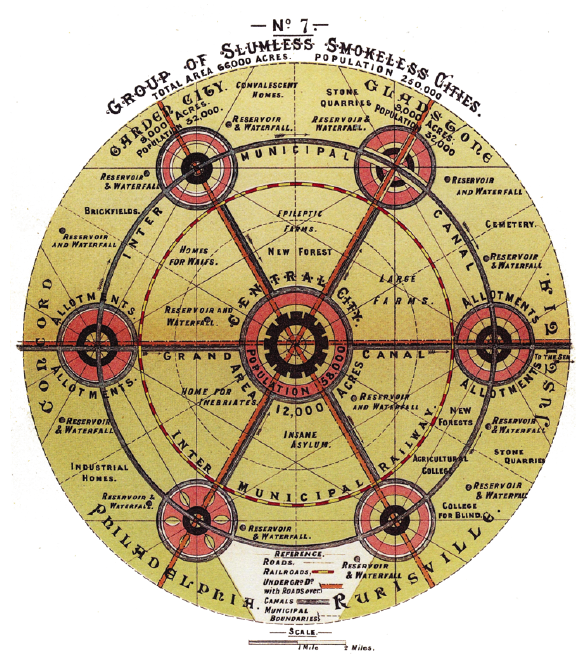
Figure 2. Diagramme no. 7: “Social Cities”. Source: Howard